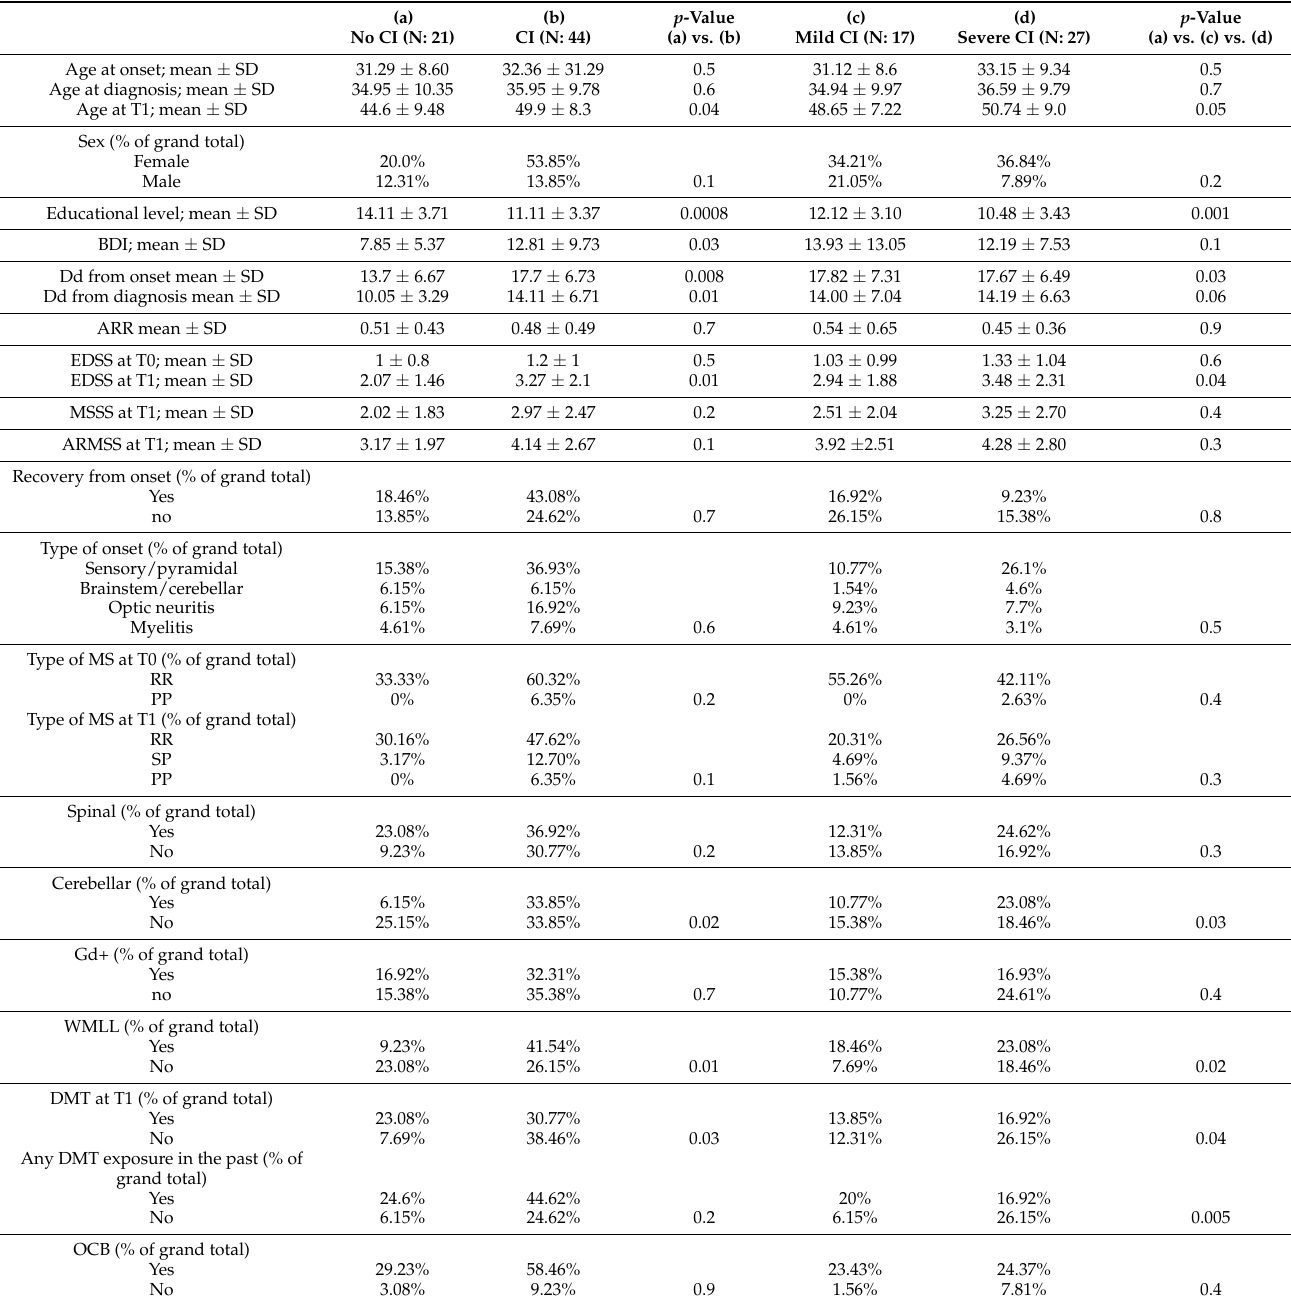
Table 3. Cognition and prognostic